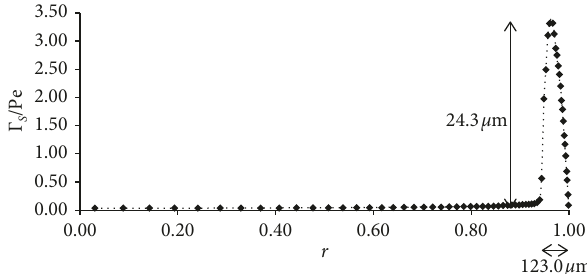
Figure 14: Deposition profile for the case of water sessile drop suspended with Si particles (Pe � 138.5; Da � Da − 1 � 0; initial particle concentration � 0.65 wt.%; initial AR � 0.5, H �